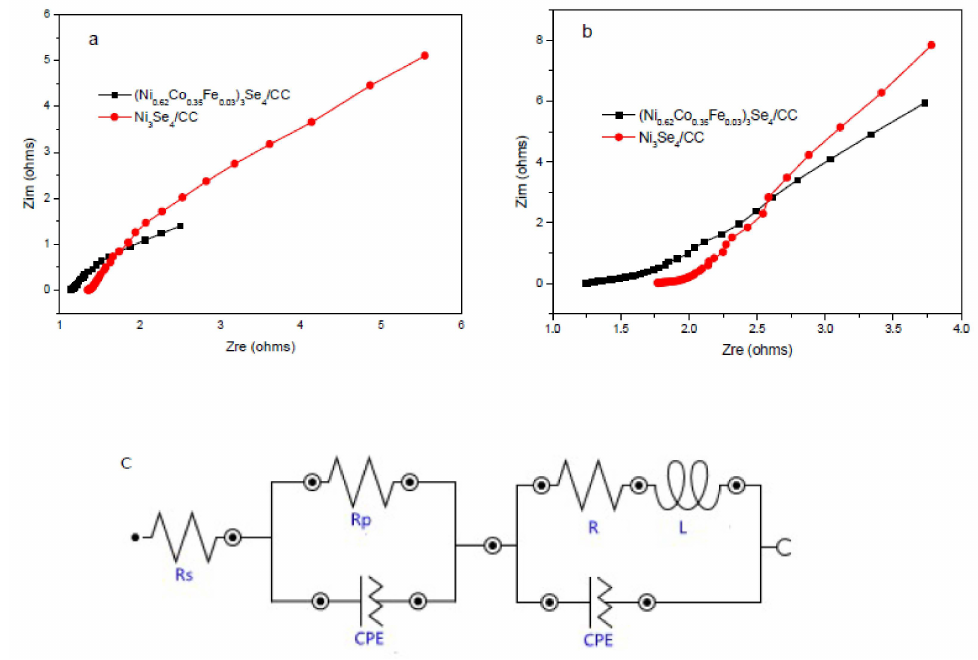
Figure 8. EIS diagram of (Ni 0.62 Co 0.35 Fe 0.03 ) 3 Se 4 /CC, Ni 3 Se 4 /CC In acidic ( a ); alkaline solutions ( b ); and analog circuit diagram ( c ).